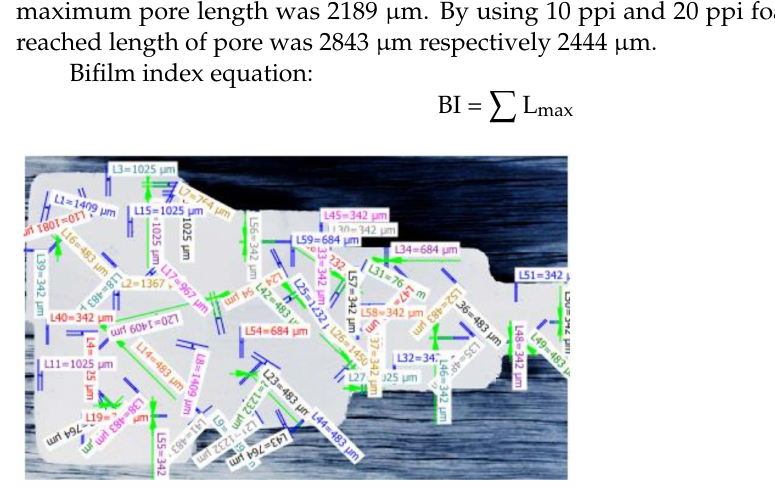
Figure 14. Bifilm index examination on the sample with 20 ppi foam filter and vortex element.